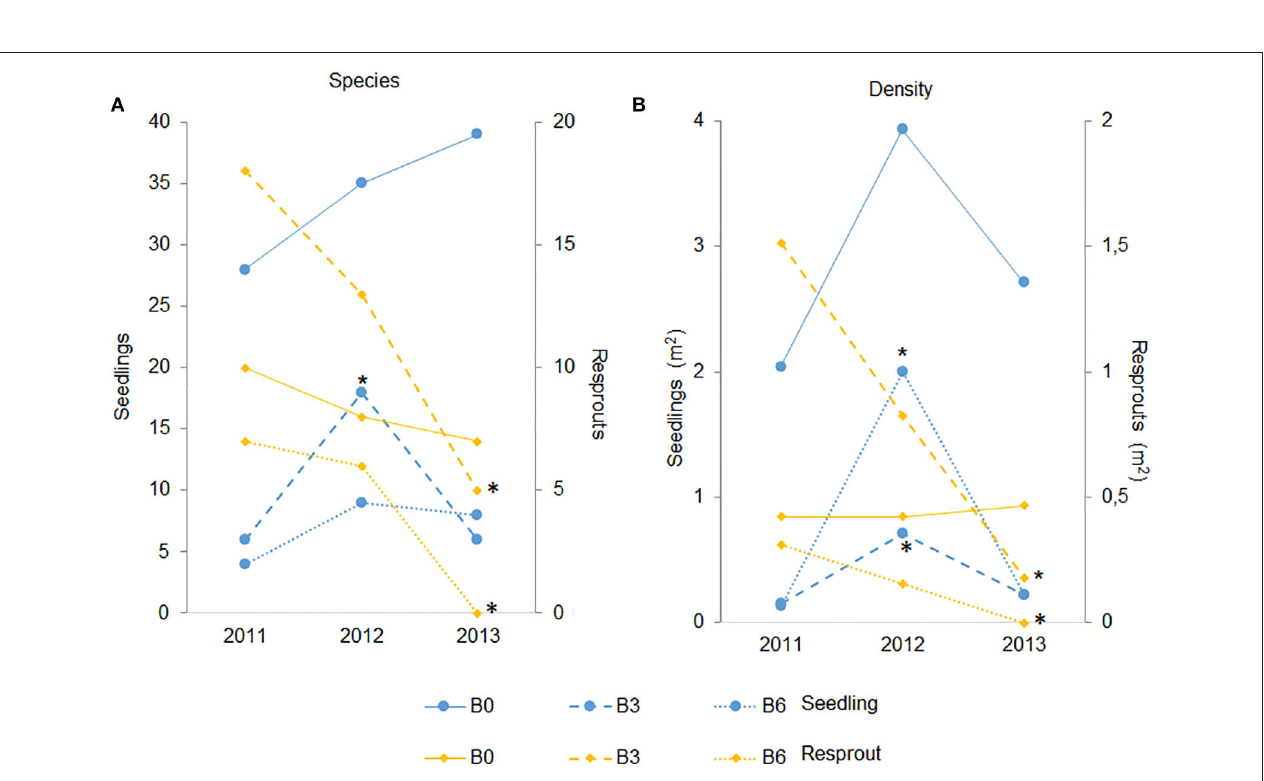
FIGURE 7 | Temporal assessment (2011, 2012, 2013) of seedlings (A) and resprouts (B) density and species richness. B0 (control ) was not burned, B3 was burned three times with 3 years interval, and B6 was burned annually, six times. Asterisks indicate differences with the first year ( P < 0.05).